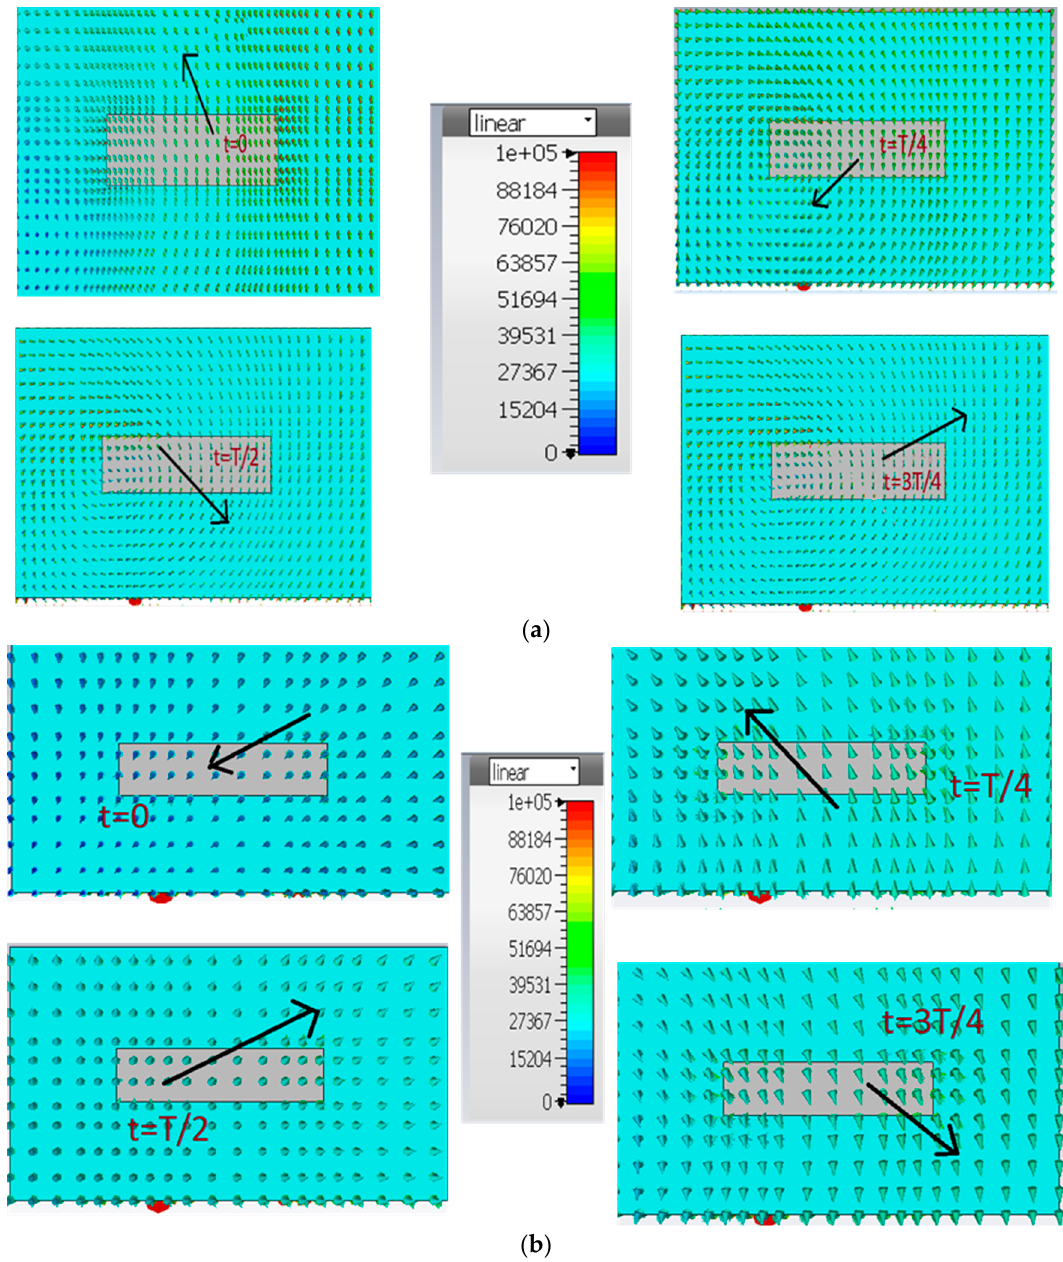
Figure 9. Simulated E-field distributions on the top view of proposed RDRA at various times. ( a ) RHCP at 3.47 GHz. ( b ) LHCP at 4.41 GHz.